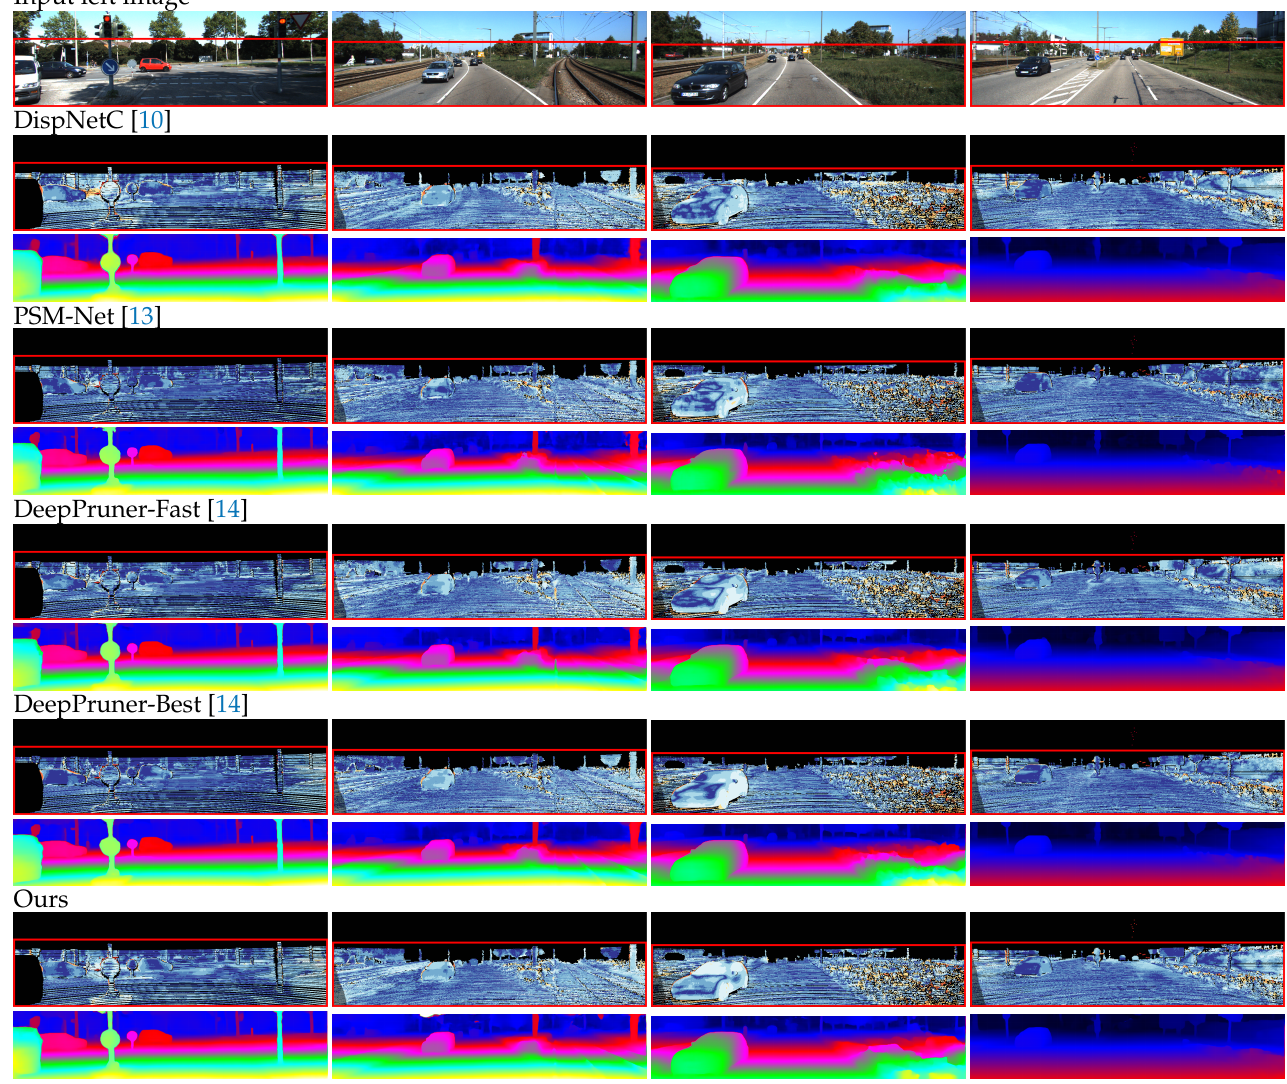
Figure 5. Qualitative comparisons on the KITTI 2015 test